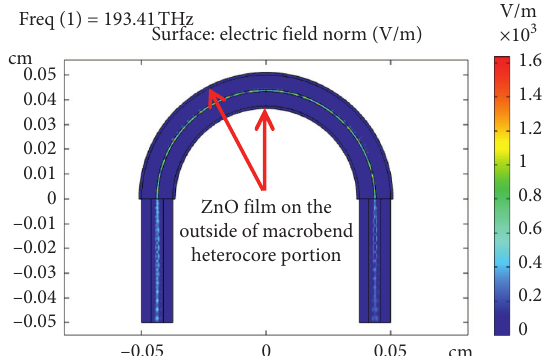
Figure 6: The electric field for different ZnO